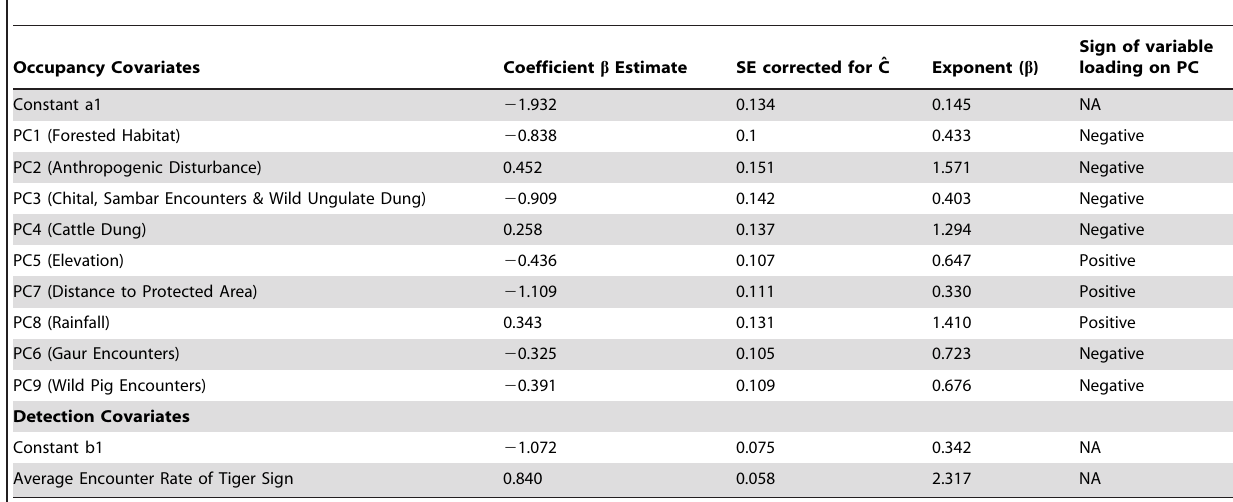
Table 9. Coefficient estimates for the best model selected for estimating tiger occupancy in the Central Indian Landscape.